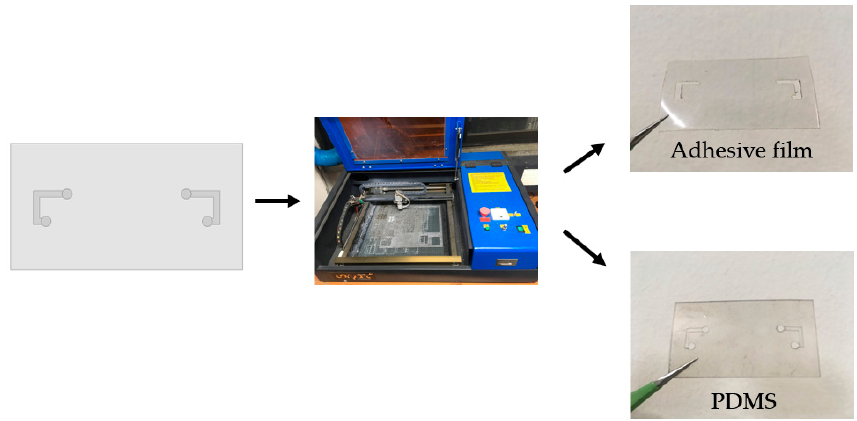
Figure 5. Fabrication process of the polydimethylsiloxane (PDMS) and adhesive film.